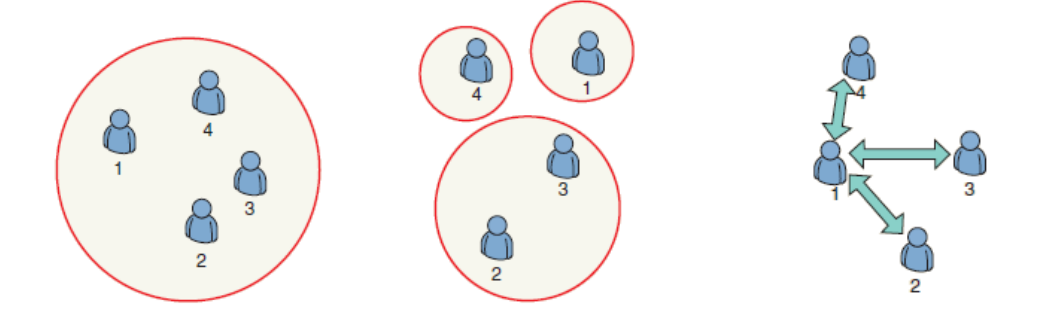
Figure 2. Classification of coalitional games: Class I, II, and III